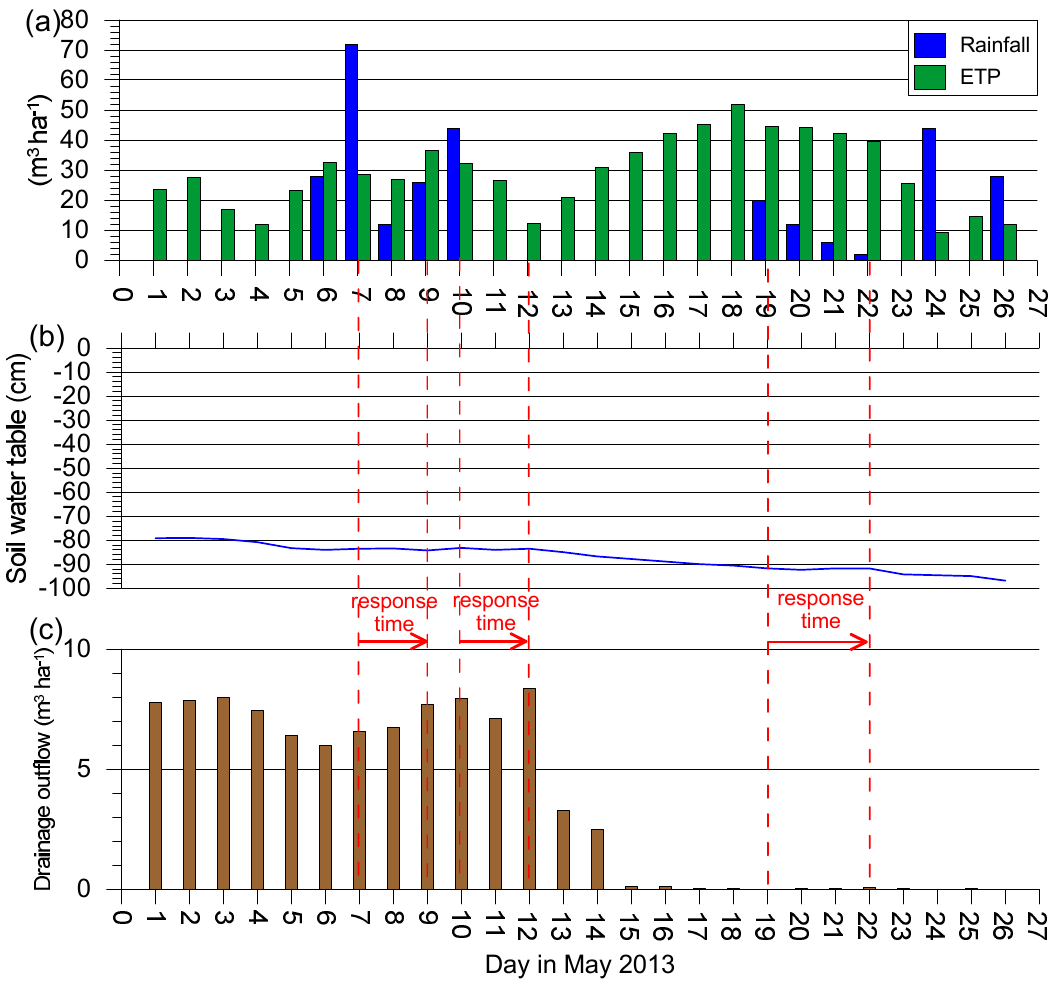
Figure 5. Daily values of precipitation and potential evapotranspiration ( a ), groundwater table ( b ), and drainage outflow ( c ) during the May 2013 observation period.